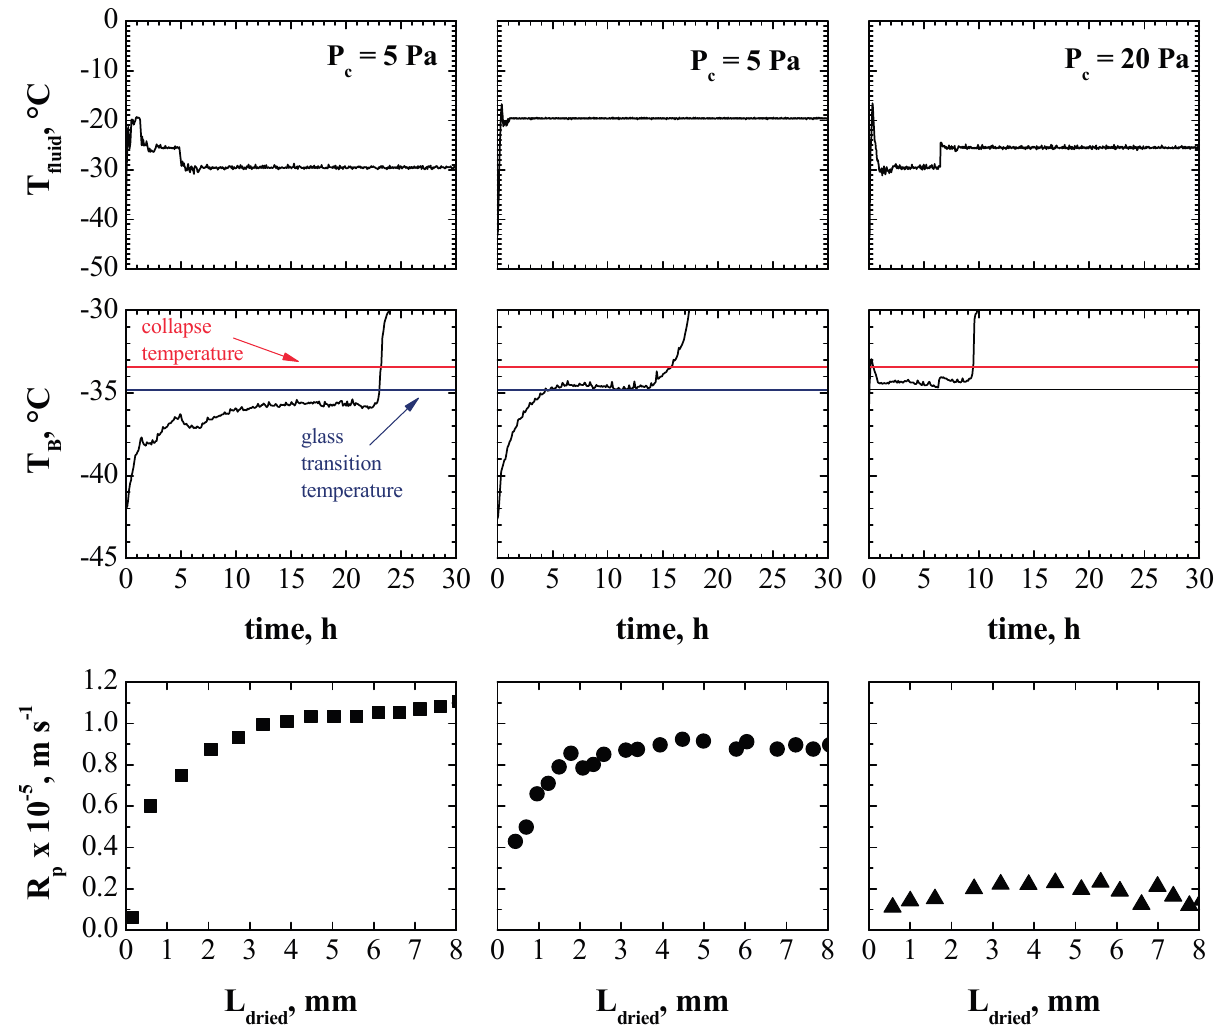
Figure 3. Comparison between the values of heating fluid temperature (upper graphs), product temperature at the bottom of the container (middle graphs) and dried cake resistance (lower graphs) in three different cycles for a 5% w/w sucrose